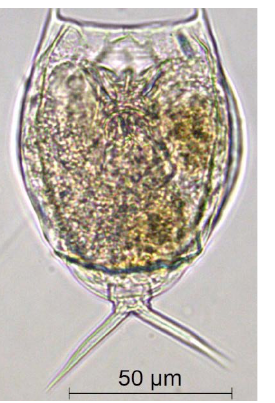
Image 7. Lepadella lindaui Koste (ventral view)